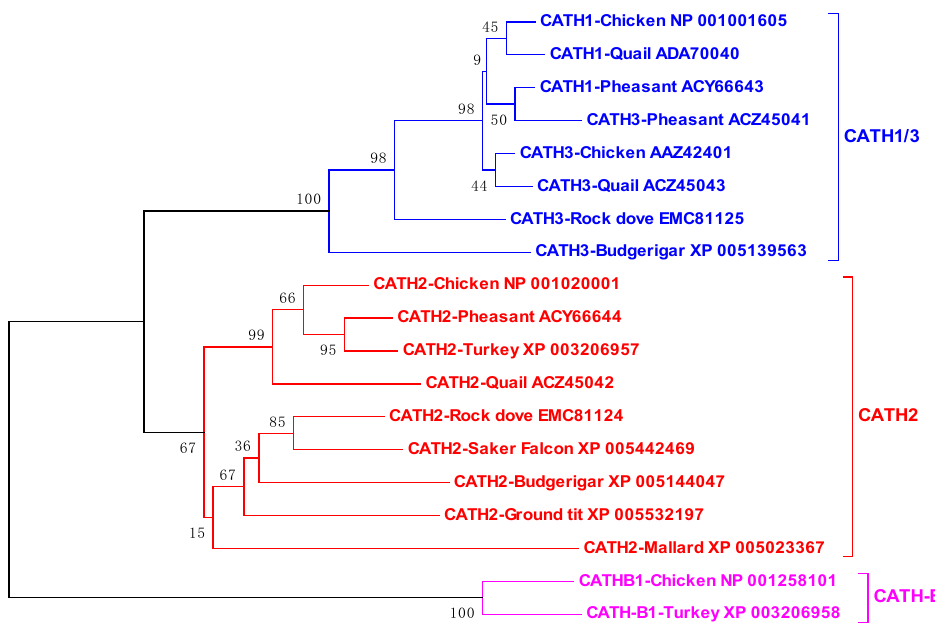
Figure 4. Phylogenetic analysis of avian cathelicidins. The phylogenetic tree was constructed with the full-length amino acid sequences using the neighbor-joining method, and the reliability of each branch was assessed by using 1,000 bootstrap replications. Numbers on the branches indicate the percentage of 1,000 bootstrap samples supporting the branch. The species and GenBank accession number of each sequence are